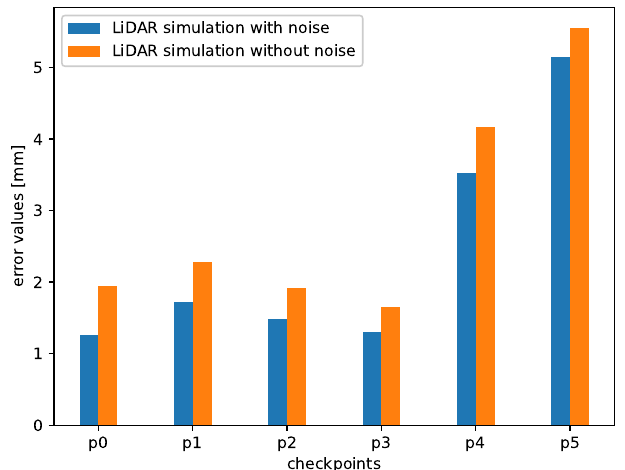
Figure 10. Mean error values between points from real and simulated point clouds (after